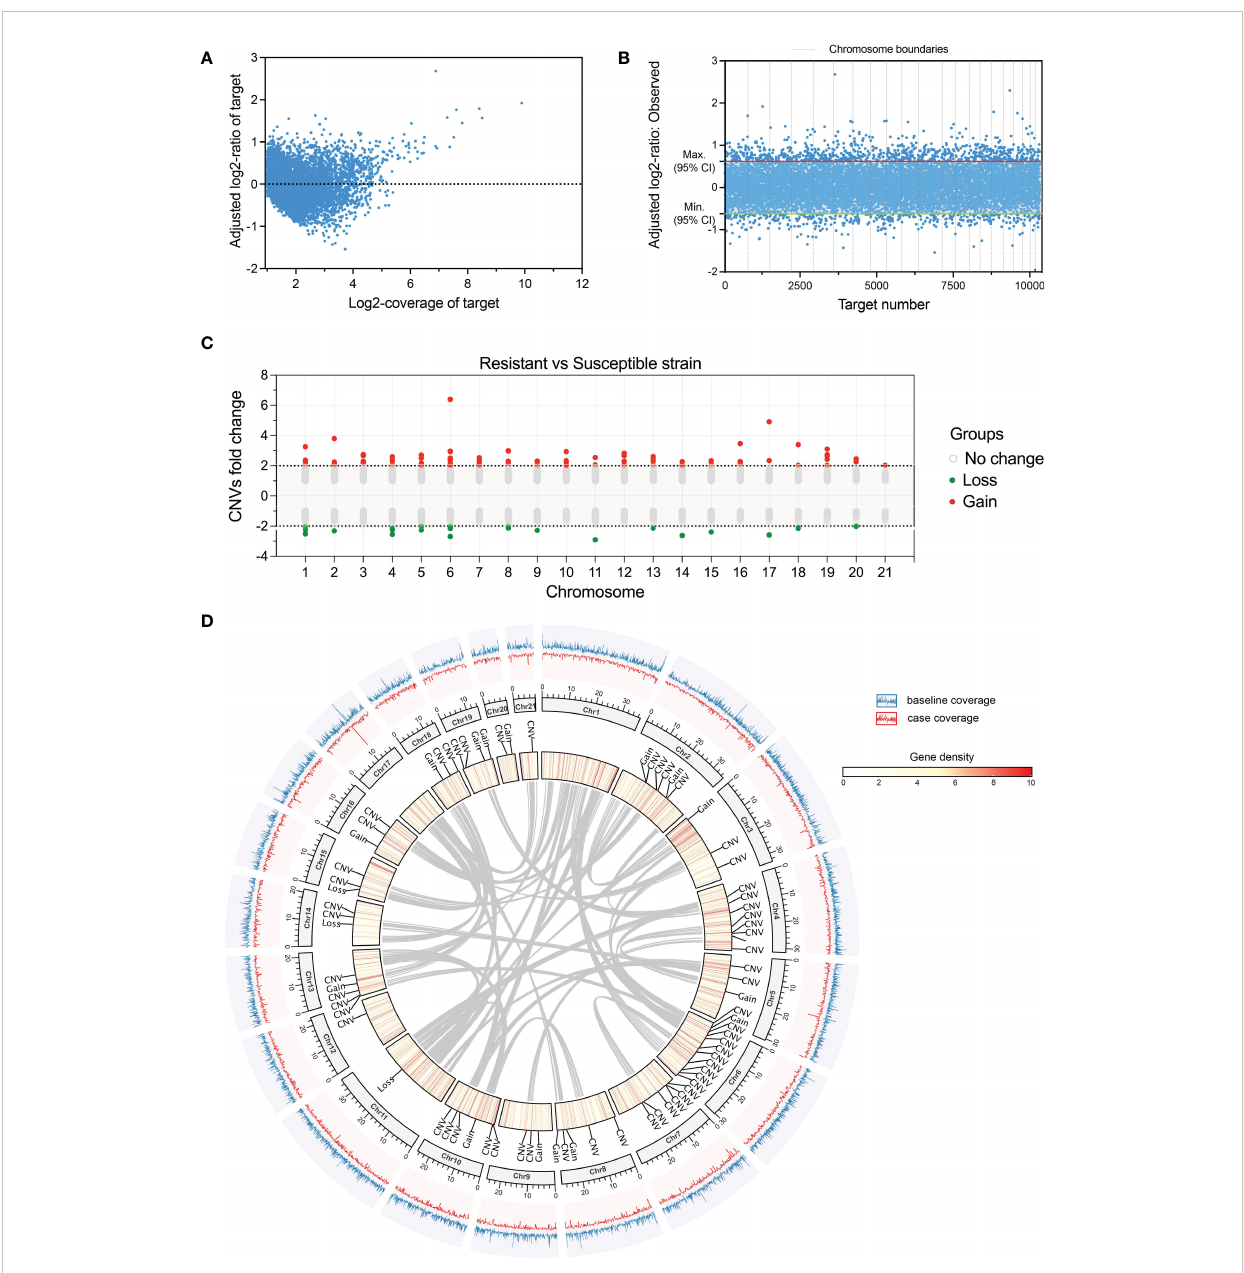
FIGURE 5 Copy Number Variations (CNVs) identi fi ed in the comparison of the resistant and the susceptible strain of sea lice. (A) “ depth of coverage ” evaluation of genes successfully mapped to the reference genome in both strains. (B) statistical signi fi cance of fold change obtained in CNV detection according to each gene (target number). (C) Fold change comparison for CNV identi fi cation in coverages from the resistant vs. the susceptible strain. (D) CIRCOS plot indicating the position of each CNV from the resistant strain and colocalization in the C . rogercresseyi genome according to gene density (track in the middle), coverage (outer track), and collinear genes (gray